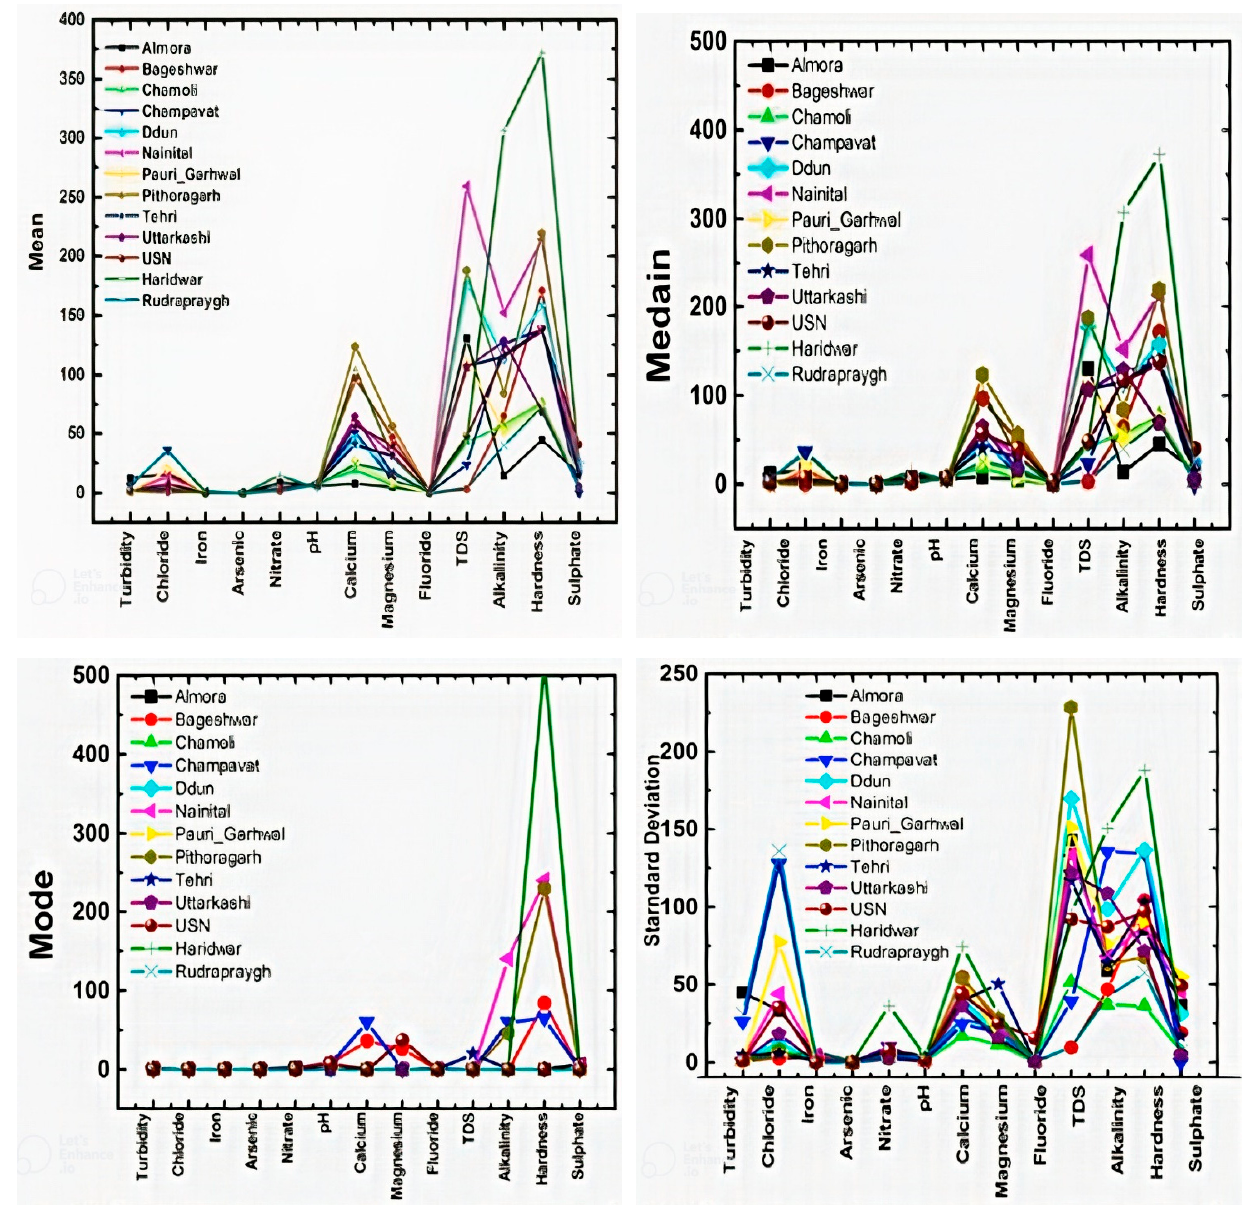
Figure 4. Statistical analysis of the GWQ parameters variation under different stress conditions.